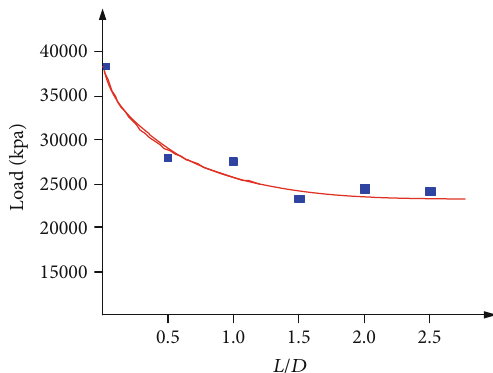
Figure 12: In fl uence of di ff erent height-diameter ratios on the maximum loading